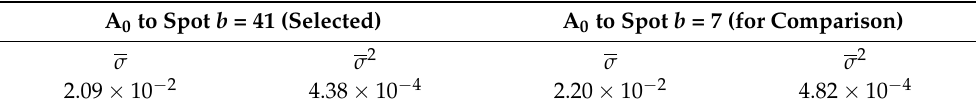
Table 2. Standard deviation and variance for A 0 to the spots 41 and 7.